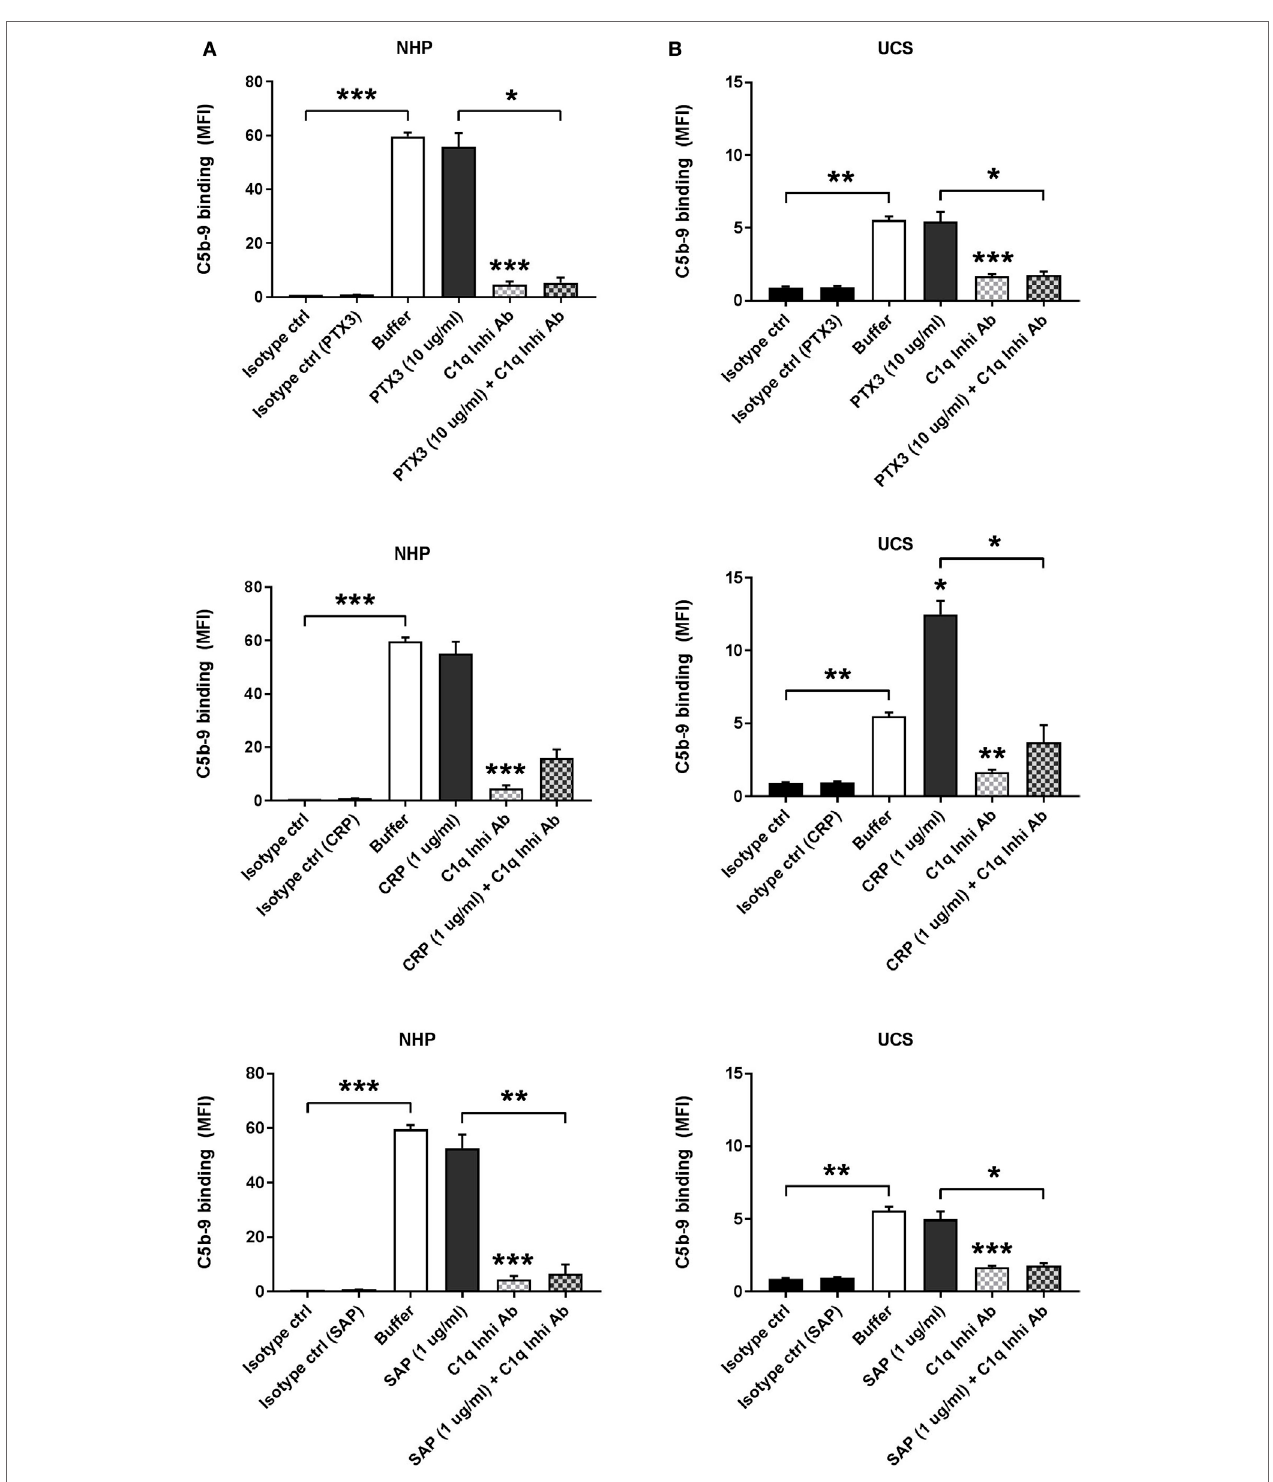
FigUre 4 | Binding of C-reactive protein (CRP) to CCs increases C1q-mediated complement activation in UCS. Complement activation was measured as C5b-9 deposition on CC and assessed by flow cytometry. (a) C5b-9 deposition on CC incubated with 10% NHP ± C1q inhibitory antibody (C1q Inhib Ab). CC were preincubated with recombinant PTX3 (rPTX3) (0 or 10 µg/mL), purified CRP (pCRP) (0 or 1 µg/mL), or purified SAP (pSAP) (0 or 1 µg/mL). (B) C5b-9 deposition on CC incubated with 10% UCS ± C1q Inhi Ab. CC were preincubated with rPTX3 (0 or 10 µg/mL), pCRP (0 or 1 µg/mL), or pSAP (0 or 1 µg/mL). Binding was assessed by MFI, and data are given as mean ± SEM ( n = 3). * p < 0.05, ** p < 0.01, *** p < 0.001 compared with buffer or as otherwise indicated. CC, cholesterol crystals; NHP, normal human plasma; UCS, umbilical cord serum; MFI, median fluorescence intensity.